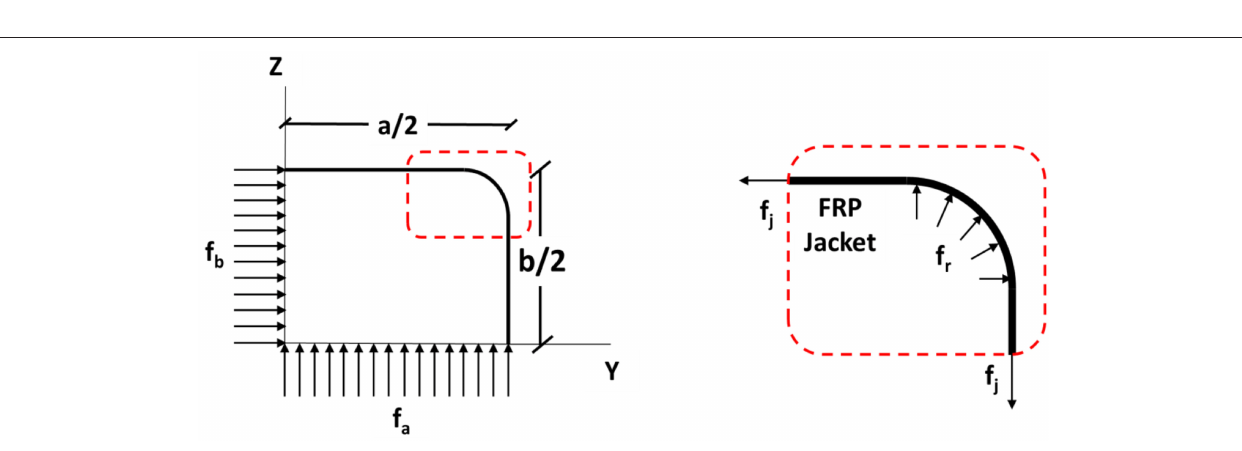
and experimental findings by Parvin and Wang (2002), and Chaallal et al.